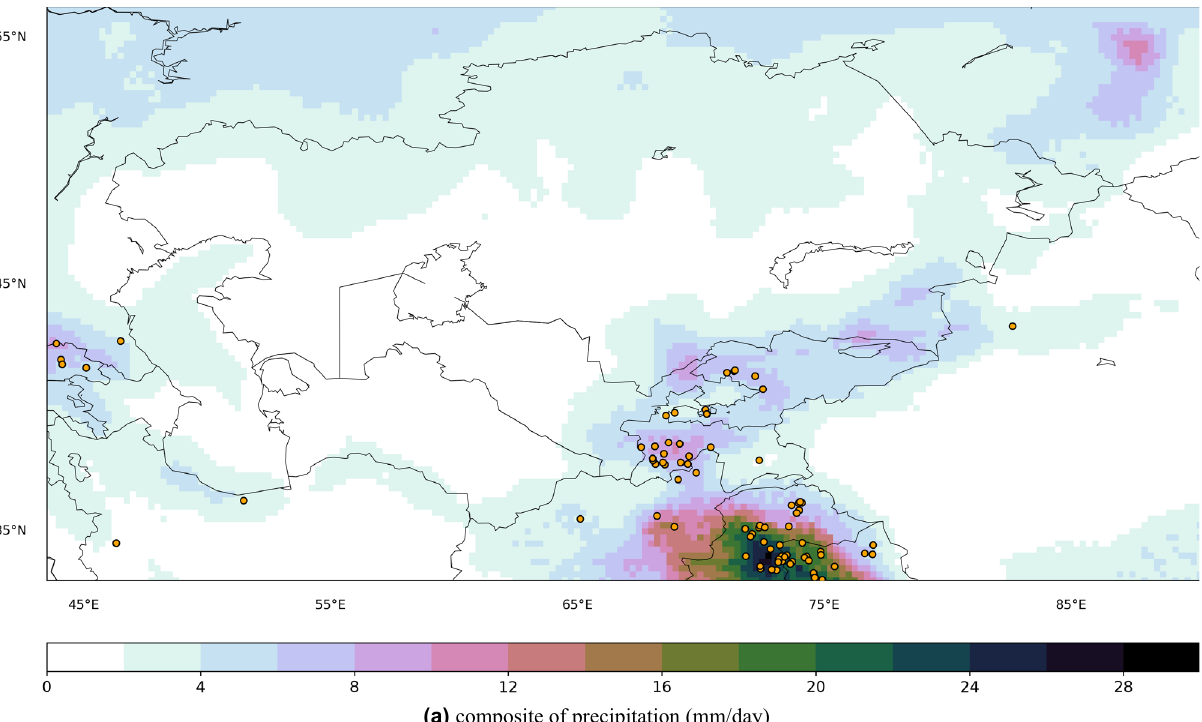
Figure 11. Composite of precipitation during the rainfall-triggered landslide events [mm/day] from CHELSA, ( b ) changes in models’ ensemble mean of the number of days with precipitations greater than 20 mm (eca r20mm) in the 1979–2014 period, i.e. hist minus hist-nat . Orange dots indicate the rainfall-triggered landslide locations from GFLD and GLC datasets. The maps were created using python3-matplotlib (version 3.1.2, https:// matpl otlib.